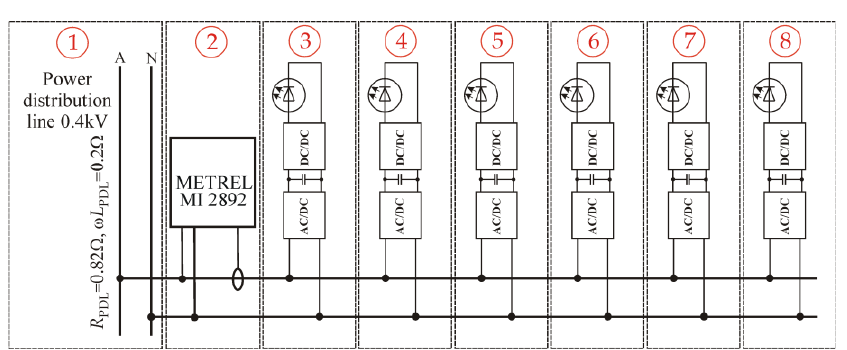
Figure A1. Circuit diagram of experimental setup for the reactive power provided by LED devices analysis.